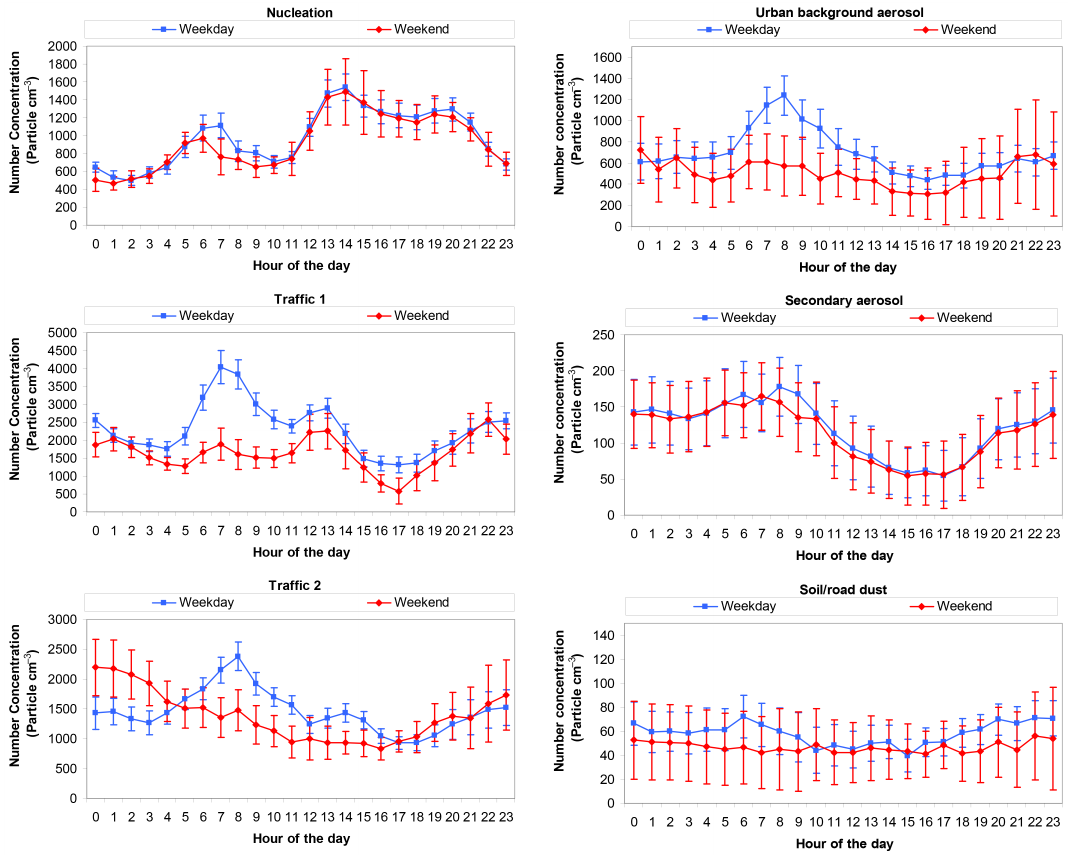
Figure 8. Weekday/weekend analysis of each of the factors resolved by the PMF model (values are geometric means). Error bars correspond to 1 standard